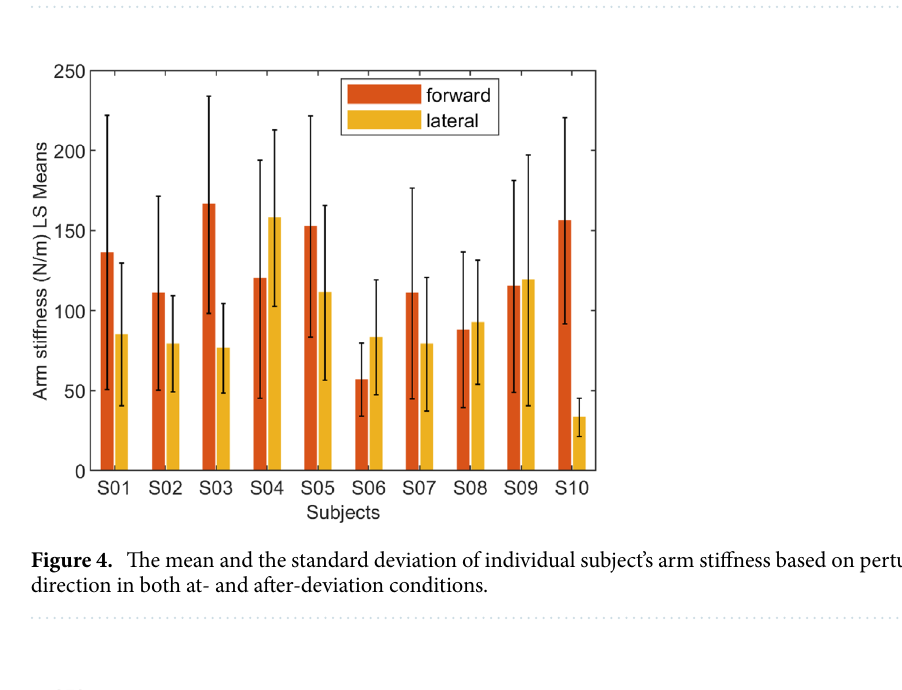
Table 1. Average stiffness across all subjects and conditions. The number of discarded trials are shown in the parentheses.